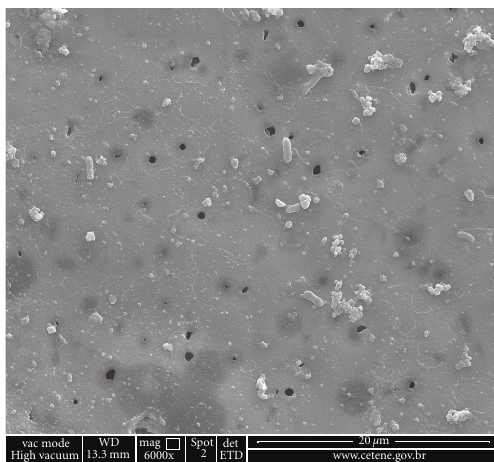
Figure 6: SEM of biofilms formed on AISI-1020 carbon steel, exposed to the fluid water + 60% B3 fuel for a period of 15 days.